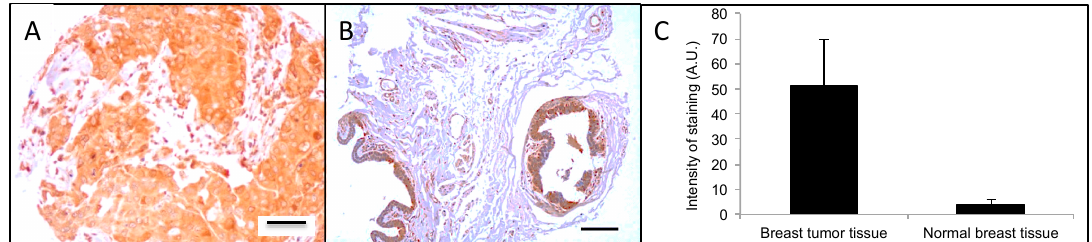
Figure 3. CrkL expression in human breast cancer microarray. ( A ) Immunohistochemistry for Crk-like protein (CrkL) in breast cancer tissue microarray (TMA) showing strong signal throughout the tissue. CrkL staining can be detected both in the cytoplasm ( bottom left ) and plasma membrane ( bottom middle ) in many tumors. In some tumors the CrkL is also found in the extracellular matrix. ( B ) Normal breast tissue showing positive staining in the ductal epithelium only. (Scale bar 4 × magnification = 500 µ m, 40 × magnification = 12.5 µ m). ( C ) Quantitation of intensity of staining through image analysis in tumor cores and normal breast tissues (excluding ductal regions), p < Table 1. Relationship between CrkL expression and pathological parameters in clinical breast tumor biopsies.